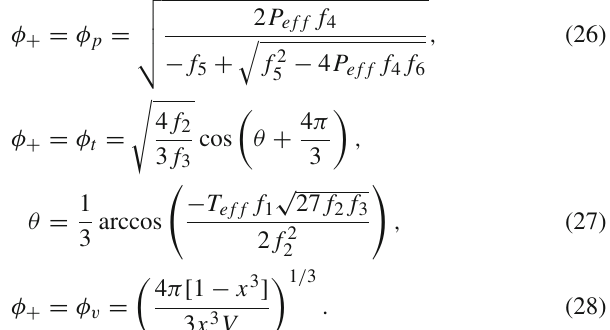
potentials on RN–dS black hole horizon φ +